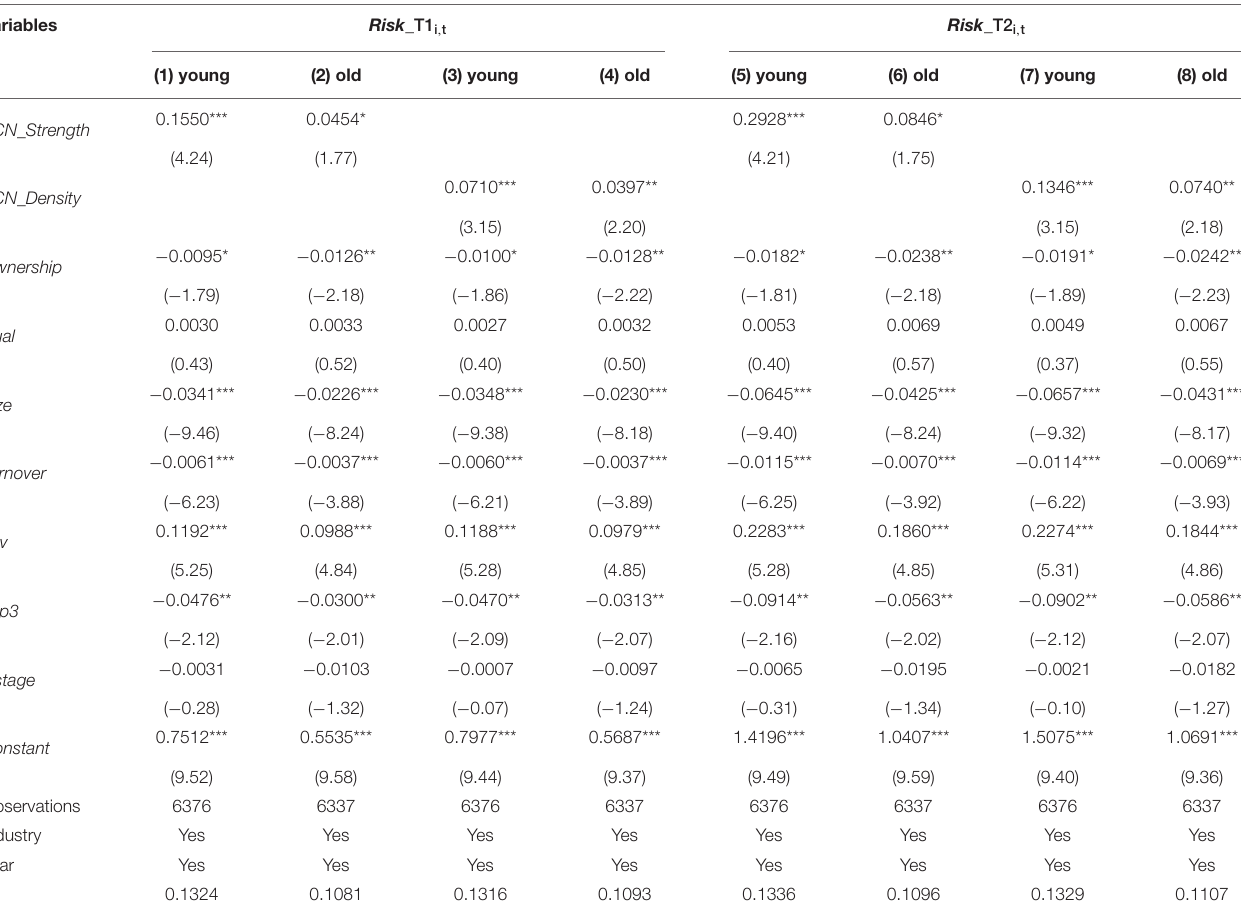
TABLE 6 | Results of young managers and old